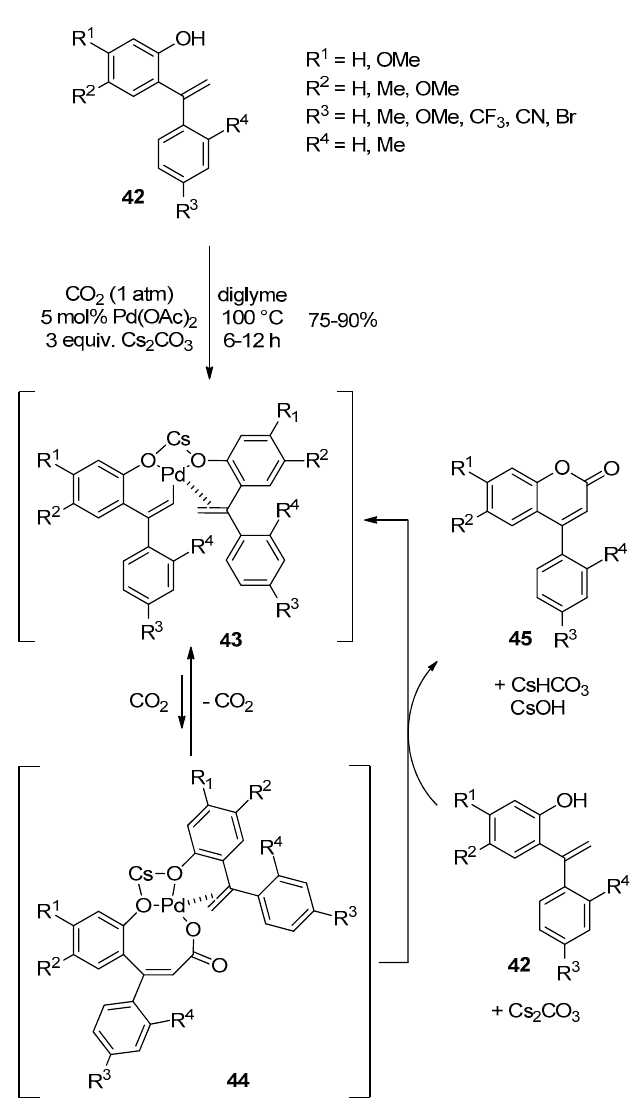
Scheme 8. Synthesis of 4-arylcoumarins via Pd-catalyzed cyclocarboxylation.